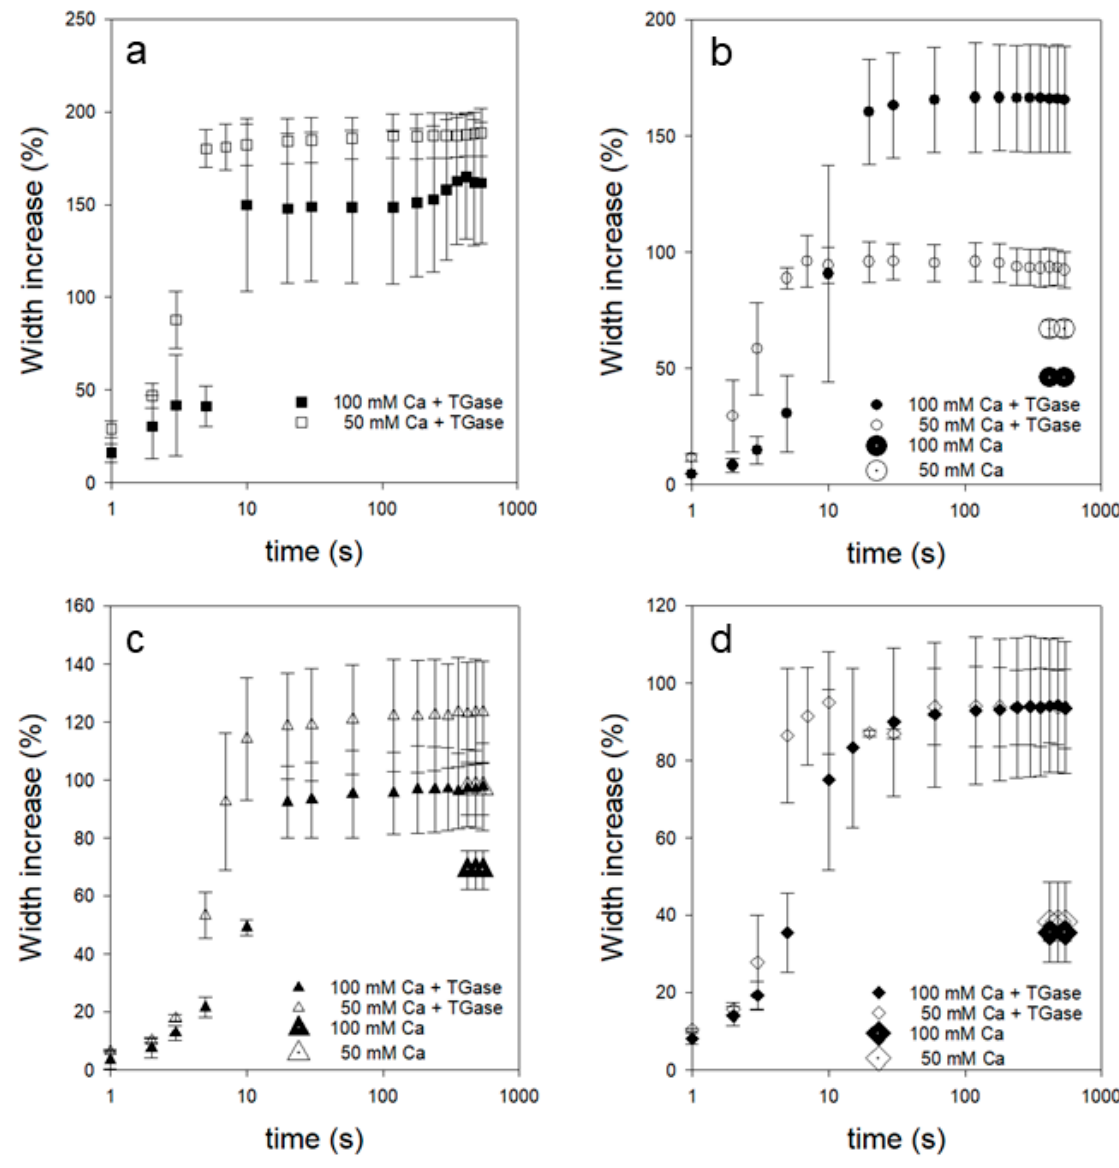
Figure 2. Swelling curves of TGase-treated and dried p -CMs fibers prepared with 50 mM CaCl 2 and 50 mM MgCl 2 (open symbols) and 100 mM CaCl 2 (closed symbols) in ( a ) NaOH, ( b ) distilled water, ( c ) SMUF, and ( d ) HCl. The reference values of maximum swelling for the samples without TGase treatment are shown as dotted symbols.